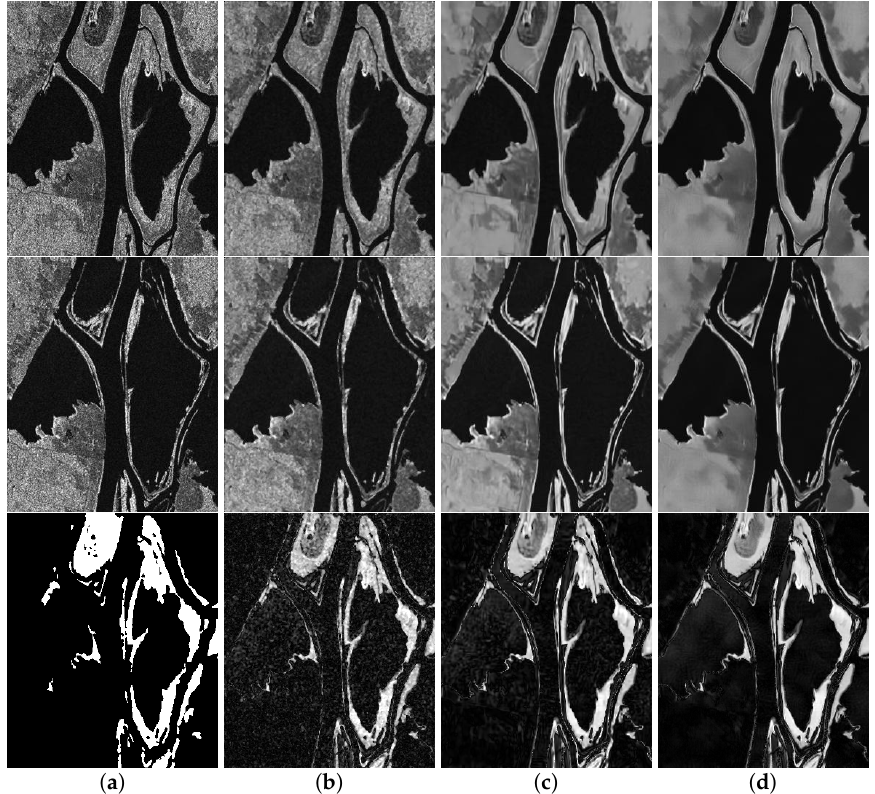
Figure 5. Ottawa dataset. ( a ) Raw images from August 1997 and September 1997 and reference map. ( b – d ) Filter images by MMSE, SAR-BM3D, PPB, and the corresponding